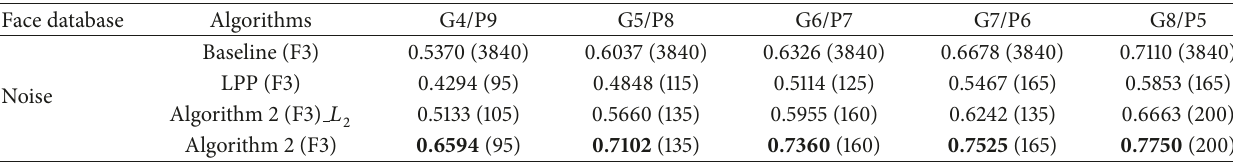
Table 11: The recognition rates on noise AR face database over “F3” features; recognition rates